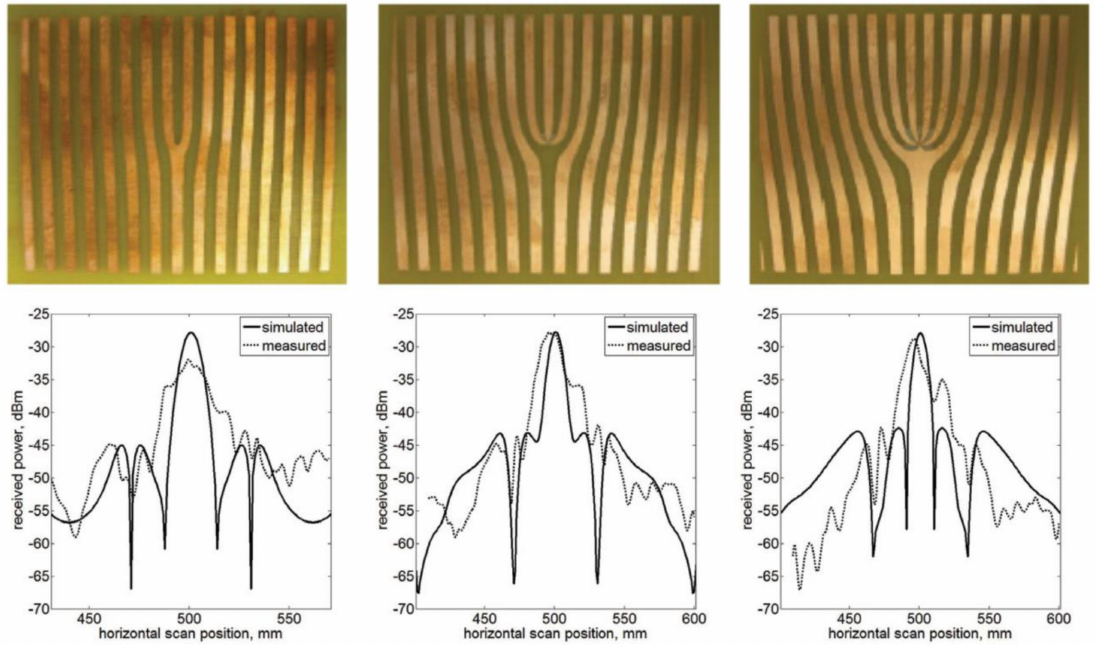
Figure 3. Designs of several holograms for orbital angular momentum (OAM) vortex wave generation and the obtained radiation patterns in far-field at 60 GHz